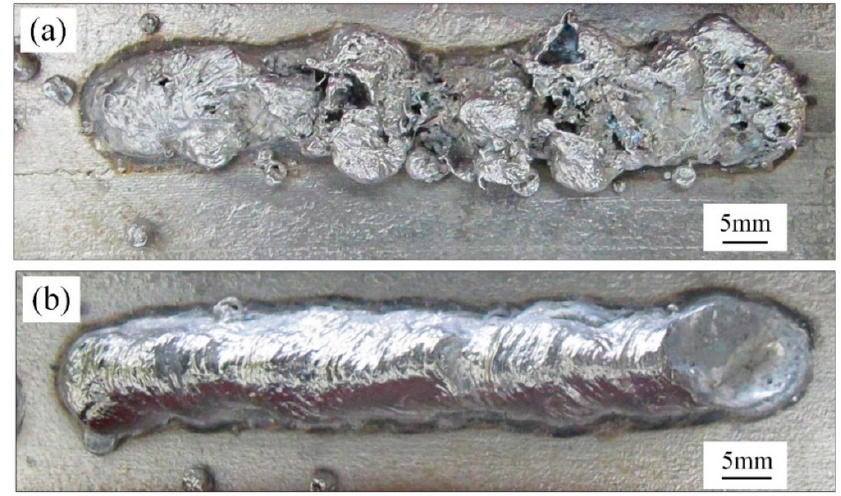
Figure 2. Weld forming ( a ) grade 1; ( b ) grade 5.